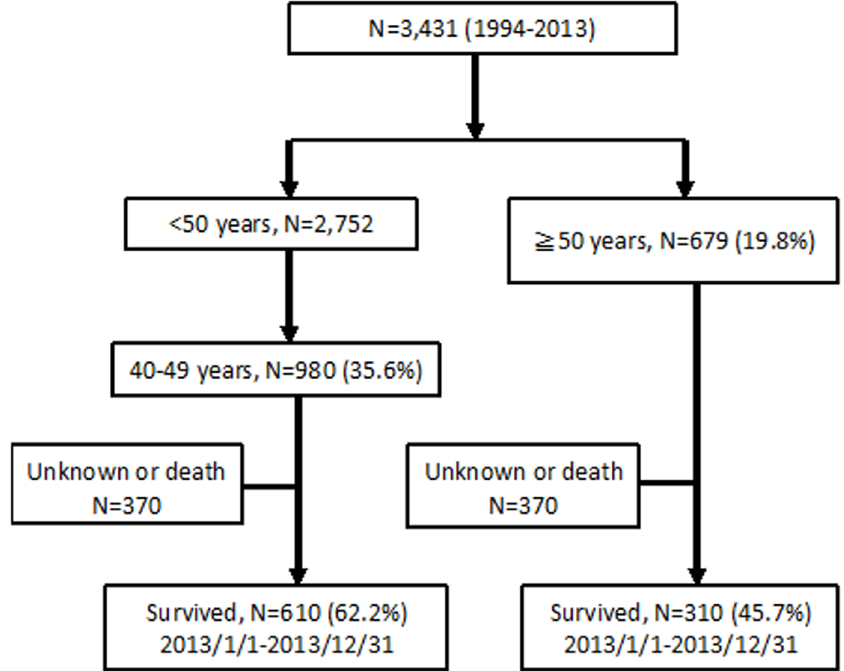
Figure 1. Study flow.